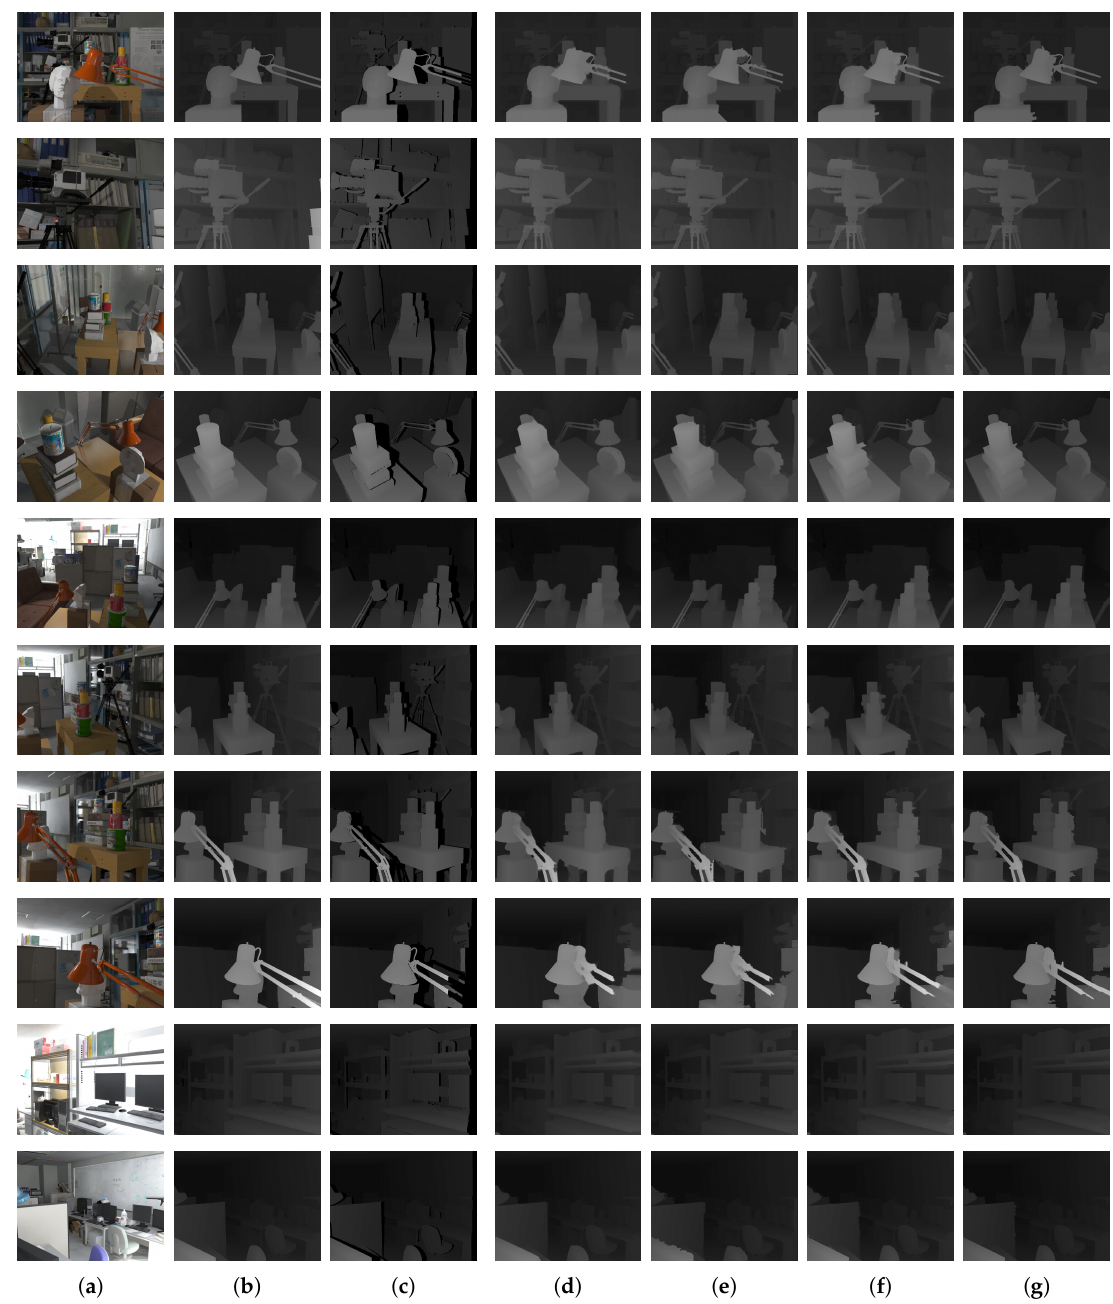
Figure 12. Experimental results using the Tsukuba Stereo Dataset (# 001; # 214; # 291; # 347; # 459; # 481; # 509; # 525; # 715; # 991). ( a – c ) are the color, ground truth of depth, and depth images, respectively; ( d ) is the method in [34]; ( e ) is the method in [31]; ( f ) is the method in [33]; and ( g ) is the proposed